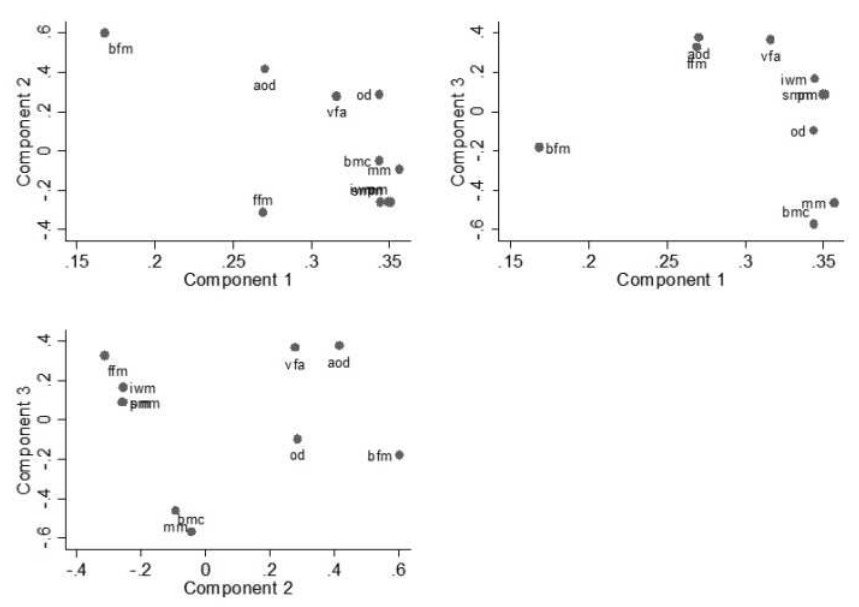
Figure 6. Component